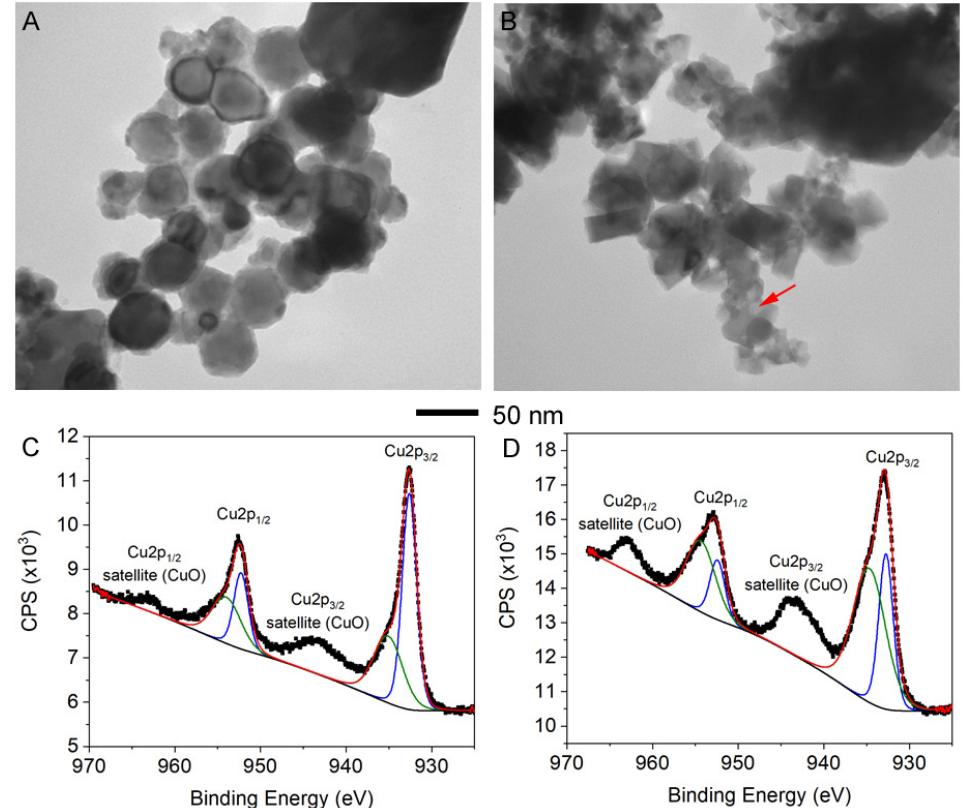
Figure 3. ( A , B ) TEM images of PEG-SH coated CuNPs after being suspended in water for 5 days indicated inhomogeneous oxidation. The surface of the CuNPs was covered by Cu 2 O/CuO with porous features indicated by a red arrow. ( C , D ) Cu2p XPS of the PEG-SH coated CuNPs freshly prepared ( C ) and after 5 days suspended in water ( D ). The red curve is the sum of blue and green curves that fit Cu2p 3/2 and Cu2p 1/2 regions with Cu/Cu 2 O and CuO, respectively.